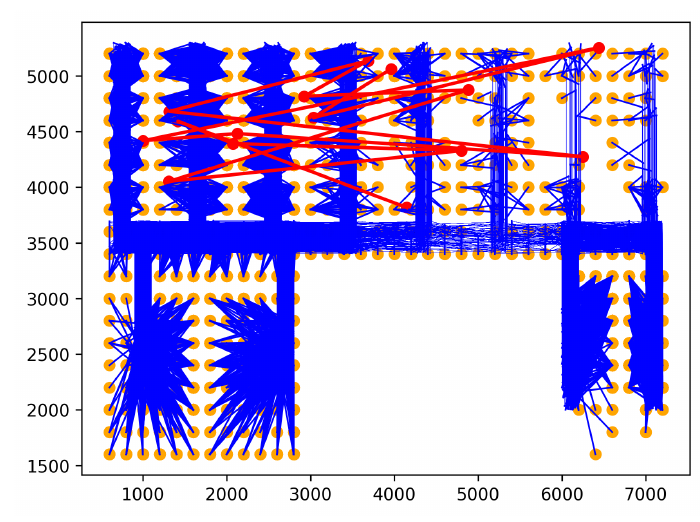
Figure 7. Random route